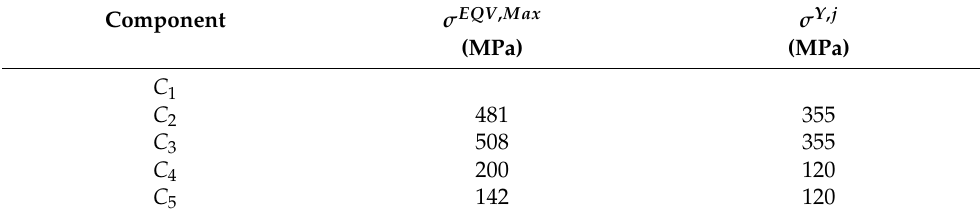
Table 7. The results for components from the Set